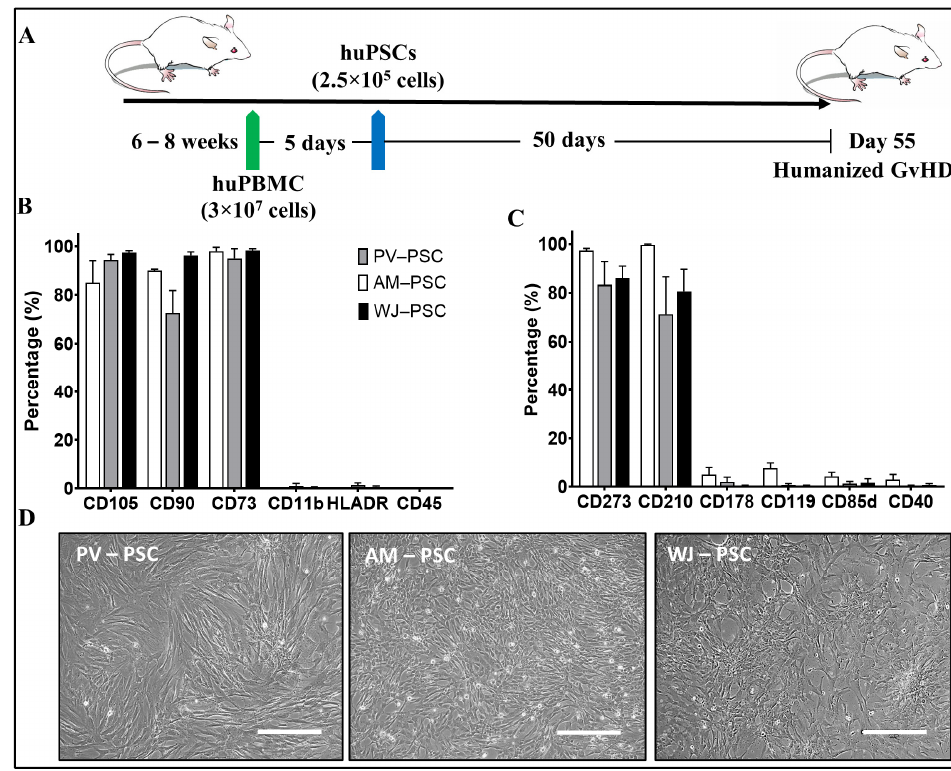
Figure 1. Graft versus host disease (GvHD) model and PSC phenotype. ( A ) Xenogeneic GvHD induction diagram (injection times, etc.). Perinatal Stromal Cell flowcytometry characterization for ( B ) mesenchymal stem cell-related markers and ( C ) immune-related markers. Representative images of PSC in vitro adherent morphology ( D ). n = 5 independent donors. Abbreviations: human peripheral blood mononucleated cells (huPBMC), human perinatal stromal cells (huPSCs), amniotic perinatal stromal cells (AM-PSC), placental villi perinatal stromal cells (PV-PSC), and Wharton’s jelly